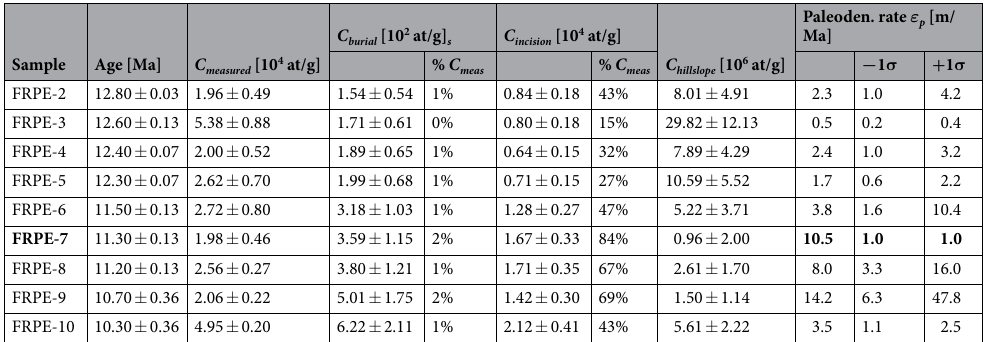
The paleo-denudation rate estimated for the youngest sample (FRPE-10, 10.3 Ma-old) falls in the same range as the oldest ones. Compilation of present-day denudation rates. Compilation of 10 Be-inferred erosion rates (Table S1)